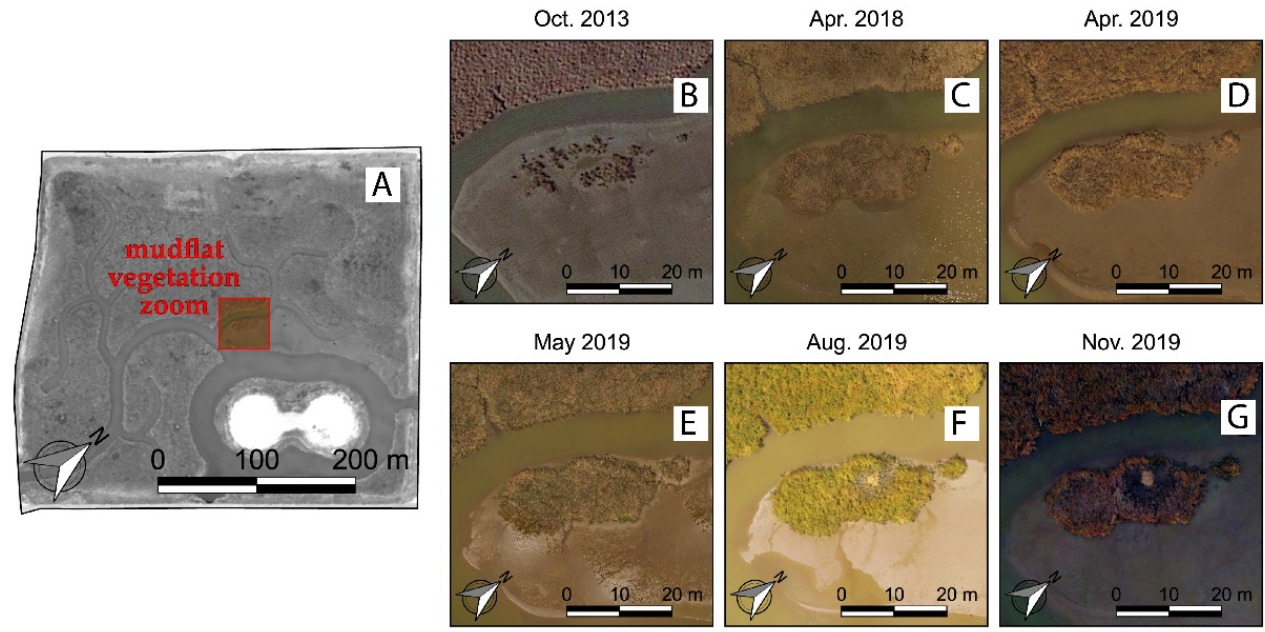
Figure 10. ( A ) Position of the mudflat. ( B ) image of the mudflat from Google Earth (October 2013). ( C – G ) refer to S. alterniflora vegetation from orthomosaic images, respectively of April 2018, April 2019, May 2019, August 2019 and November 2019. ( B – G ) represents a zoom of the red square in plot A